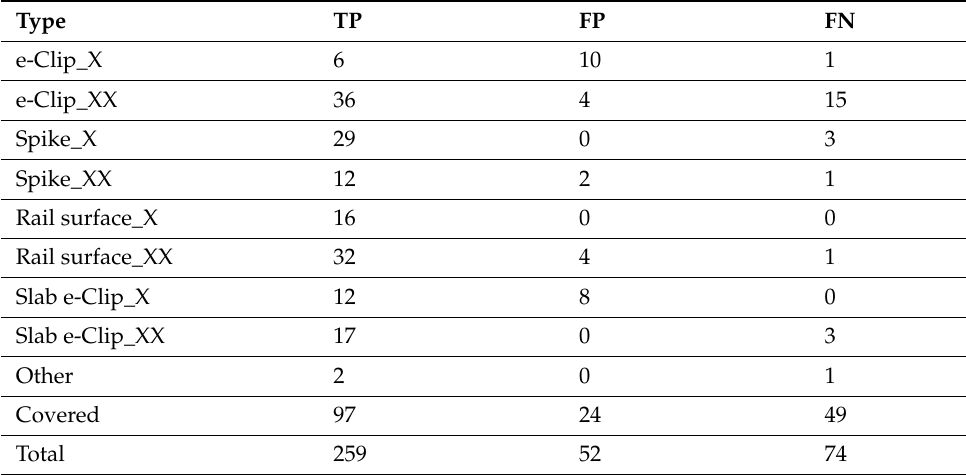
Table 13. YOLOX-Tiny training results for each defective type in the top view.